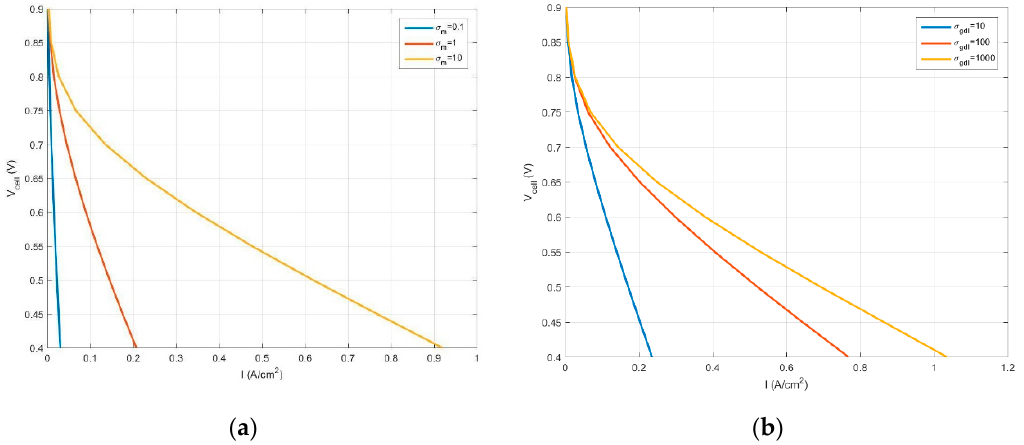
Figure 9. Effect of ( a ) ionic and ( b ) electric conductivity on the HT-PEMFC performance at 180 °C.